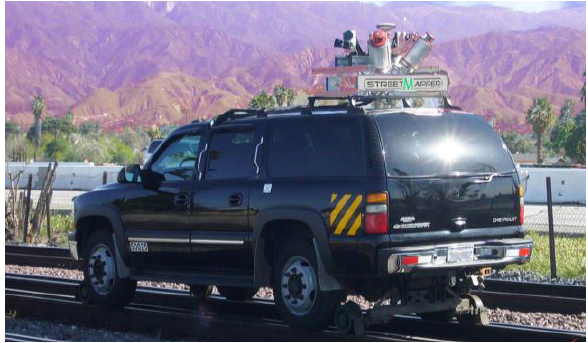
Figure 3: StreetMapper operated on a hi-rail gear vehicle (Photo: Terrametrix LLC, Omaha, NE, USA)